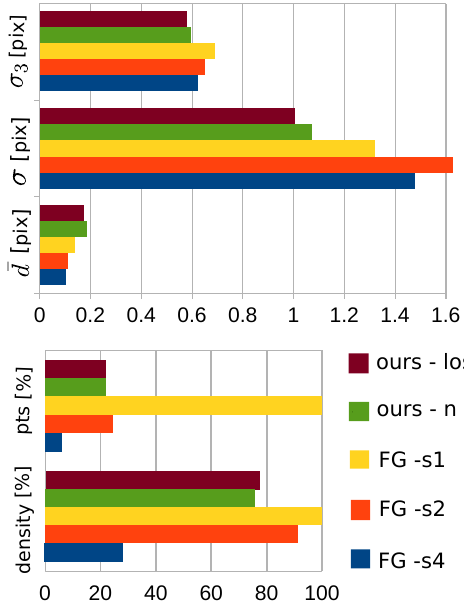
Figure 5: Mean differences, standard deviations and density anal- ysis for the sub-area of the fountain dataset displayed in figure